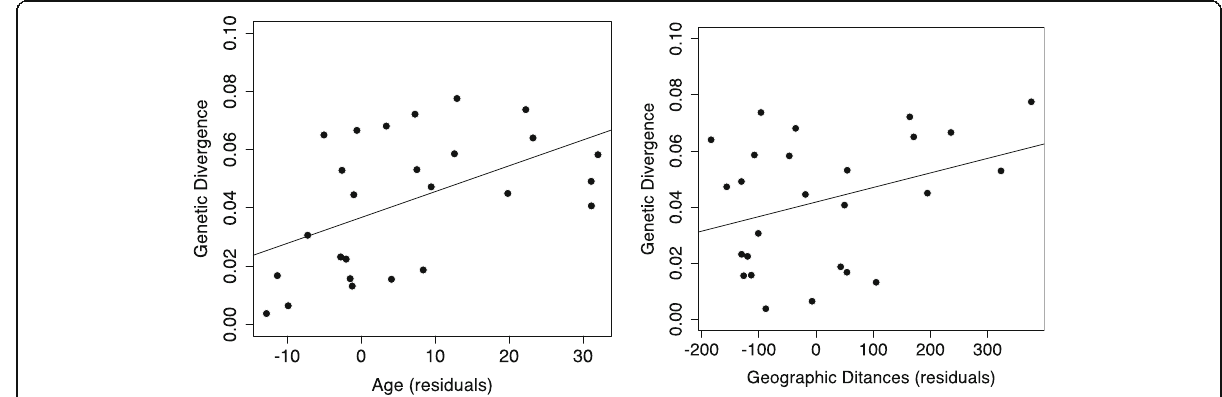
Fig. 3 Relationship between average genetic divergences of species and species ages ( a ) and average geographic distances ( b ); residual regression values for species age and geographic variances vs. average genetic divergences were